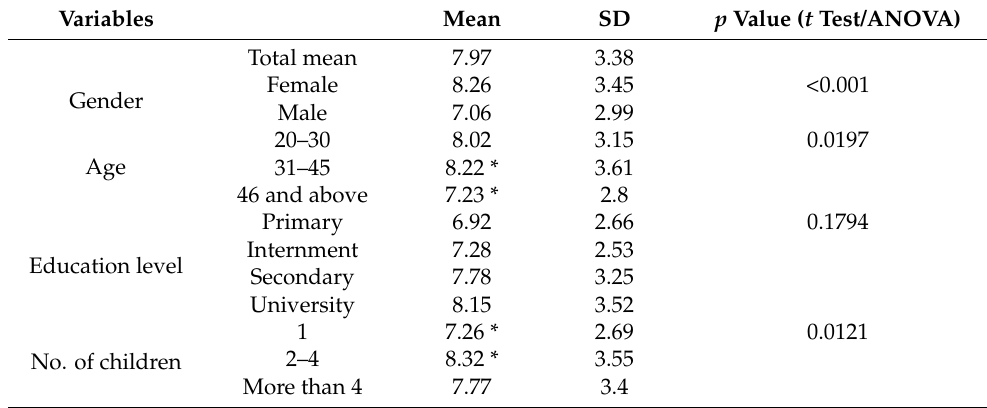
Table 4. Comparison of mean knowledge score of participants according to demographic